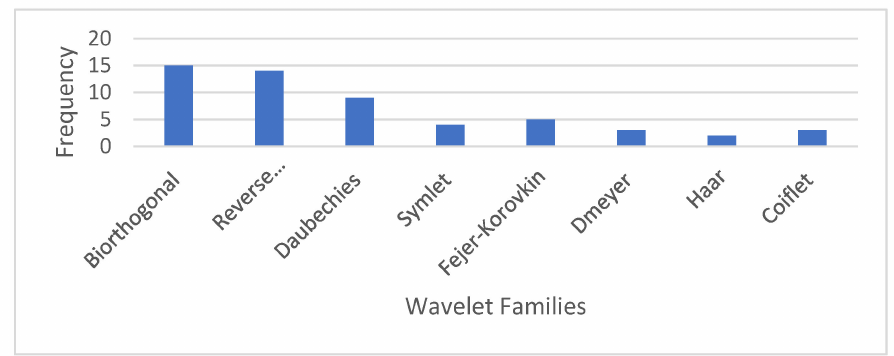
Figure 5. Frequency of selection of each wavelet family at each node of the GPCR hierarchy.